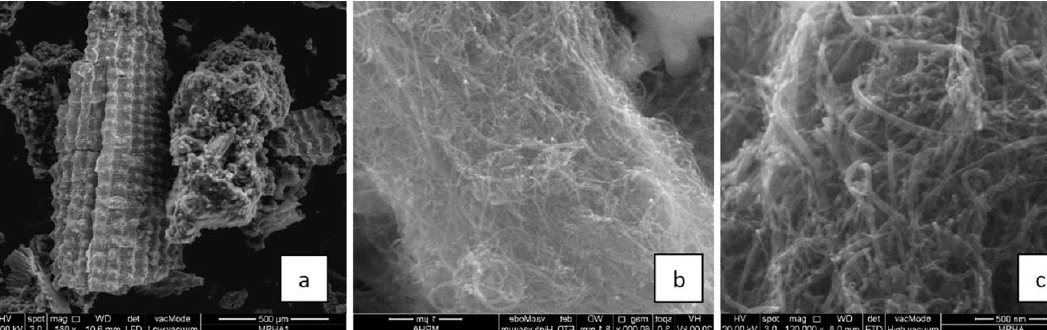
Figure 4. Surface and cross-sectional morphology of rice husk ash biopolymer after coating with CNFs, ( a–c ) for different scales [47] (Reproduced with permission from publisher).